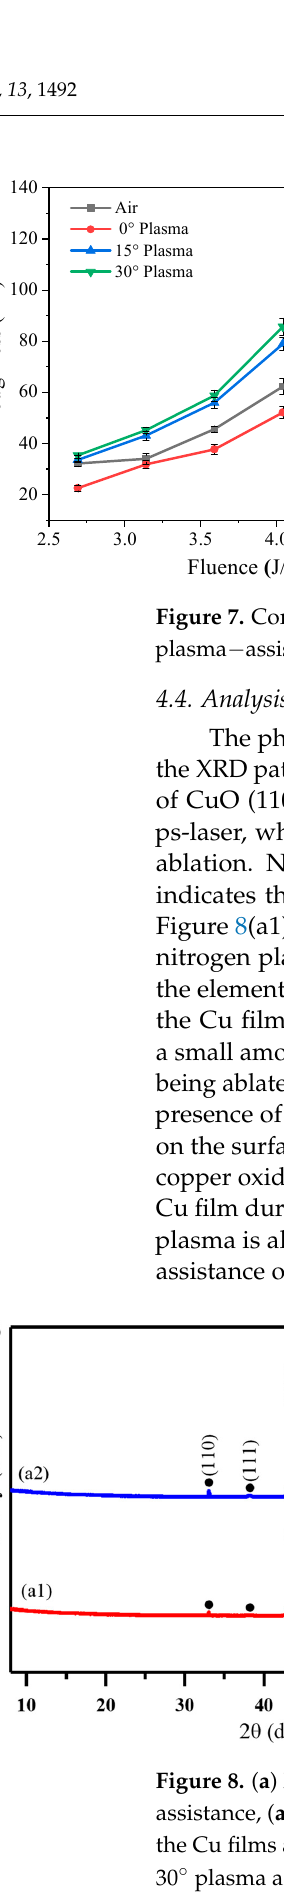
9 of 13 Figure 6. Surface morphologies and 3D morphologies of Cu films ablated by the 30° nitrogen plasma − assisted ps − lasers at different laser fluences: ( a ) 2.69 J/cm 2 , ( b ) 3.14 J/cm 2 , ( c ) 3.59 J/cm 2 and ( d ) 4.04 J/cm 2 . Figure 7 shows the surface roughness and removal depth of Cu films ablated by a nitrogen plasma-assisted ps-laser with different laser fluences at different plasma action angles. As shown in the figure, the surface roughness and the ablation depth are positively correlated with the laser fluence. This is because the Cu film absorbs more energy, and the ablation is more intense under the irradiation of a ps-laser with high fluence. In Figure 7a, the surface quality of the Cu films ablated by a 0° plasma-assisted ps-laser is always better than that of the Cu films without plasma assistance due to the shielding effect of the plasma flow. However, when the angle is increased to 15° and 30°, the surface quality of the Cu films ablated by the plasma-assisted ps-laser is always lower than that of the Cu films without plasma assistance due to the promoting effect of plasma on laser ablation. In contrast, as can be observed in Figure 7b, the 15° and 30° nitrogen plasma assistance increase the removal depth of Cu film, while the 0° nitrogen plasma assistance reduces the removal depth. This is because the plasma flow at 0° is parallel to the Cu film and gathers above the Cu film to form a protective layer, thus weakening the laser ablation. At 15° and 30°, the plasma can act directly on the surface to clean the molten particles, thus promoting laser ablation. For example, at a laser fluence of 2.69 J/cm 2 , the removal depth of the Cu film ablated by a 30° plasma-assisted ps-laser is improved by 290% com-